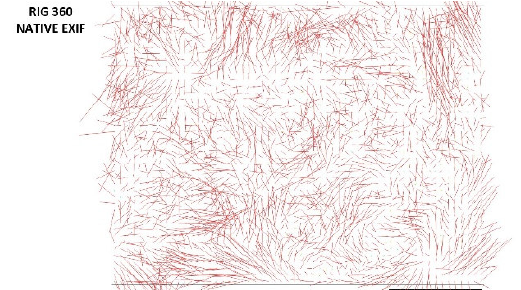
Figure 7. Image residuals for the 360 configuration automatically processed with the native Exif.